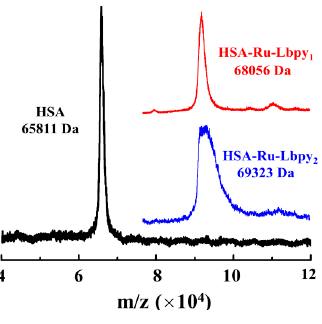
Figure 5. Matrix assisted laser desorption ionization-time of flight mass spectrometry (MALDI-TOF) mass spectra of HSA alone (black), Ru-Lbpy 1 -HSA complex (red) and Ru-Lbpy 2 -HSA complex (blue) in the 2,5-dihydroxybenzoic acid (DHB) matrix, respectively. To observe the effect of [RuCl(qn)(Lbpy)(NO)]X complexes with HSA on the NO